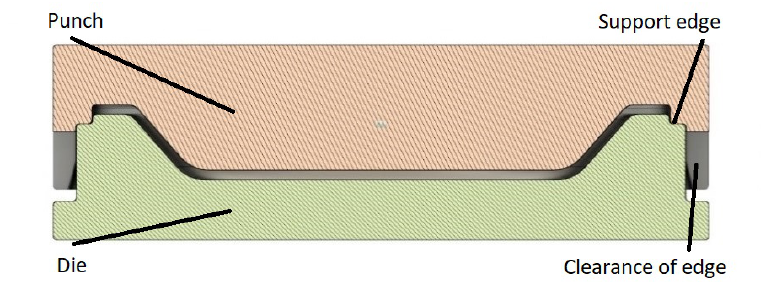
Fig. 3. Cross-section of the moulding’s